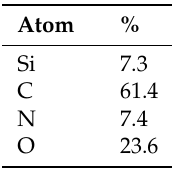
Figure 2. ( a ) XPS survey of PolyCat-Si; ( b ) deconvoluted C 1s spectrum; ( c ) deconvoluted O 1s spectrum; and ( d ) deconvoluted N 1s spectrum. Table 1. Percentage of Si, C, N, and O atoms, as determined by XPS measurements.